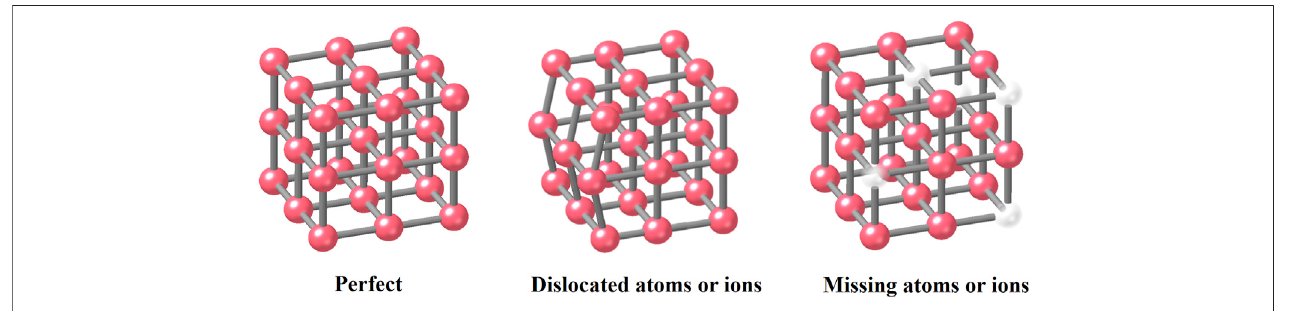
FIGURE 1 | Defect structure classi fi cation 1 with missing or dislocated atoms or ions.